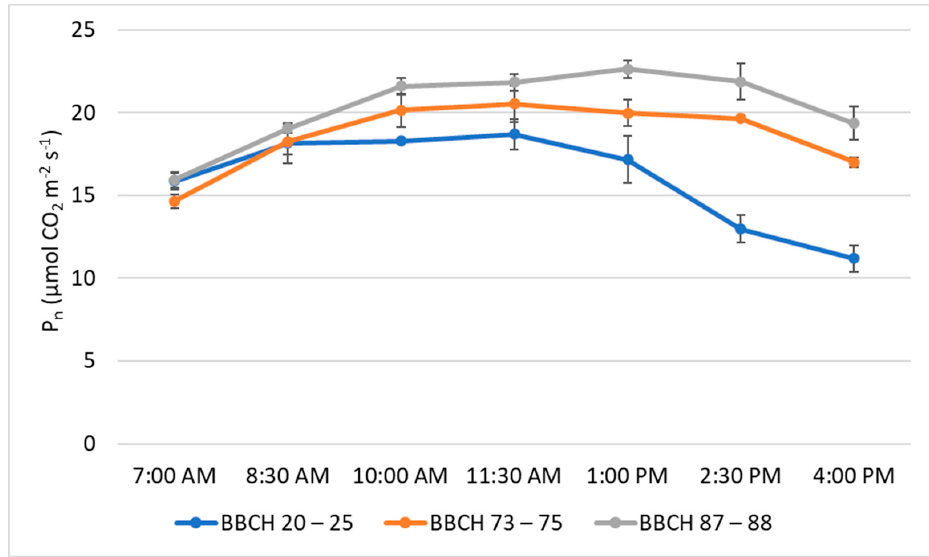
Figure 1. Dynamics of photosynthesis rate during the day in different development stages of apple trees “Auksis” with rootstock P22. The mean value (n = 9) ± standard deviation is presented.